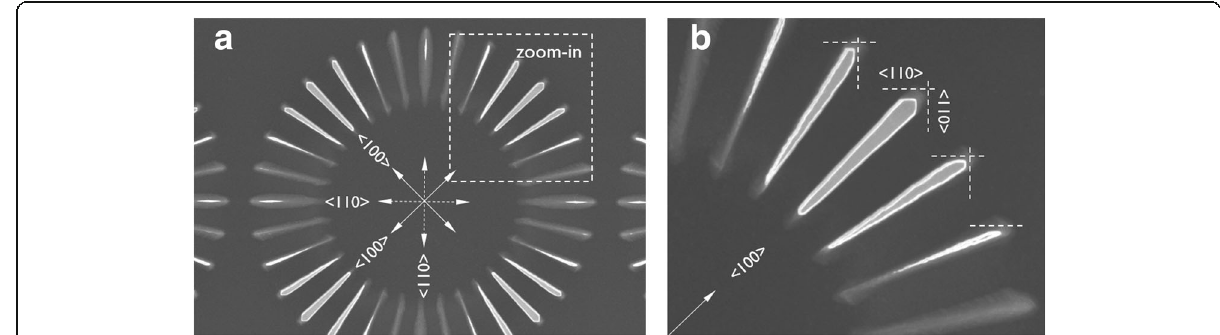
Fig. 2 a TD SEM of a Si(100) wagon-wheel etched in low-concentration TMAH (5 wt.%) at RT and zoom-in ( b ) showing the development of the faster etching {110} planes/facets, as indicated by the dashed lines